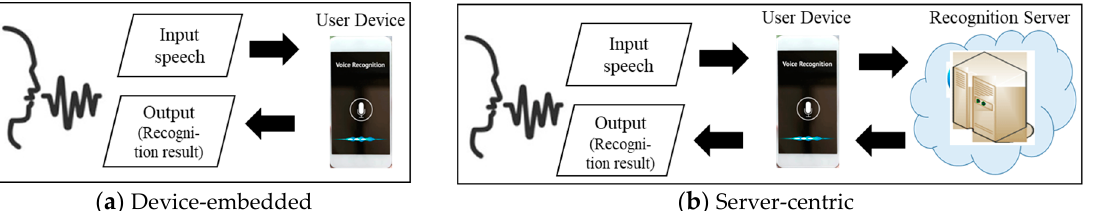
Figure A1. Comparison of device-embedded and server-centric speech recognition schemes [6]. Appl. Sci. 2020 , 10 , 6876